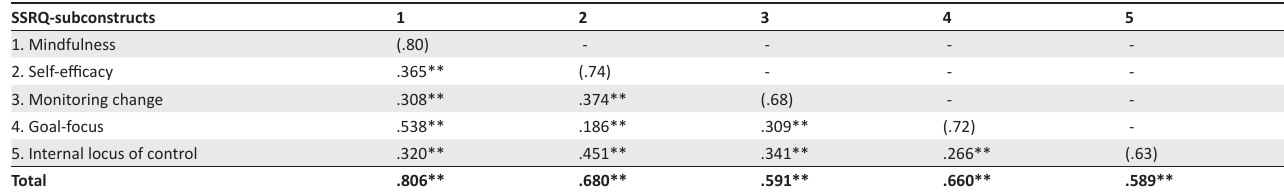
TABLE 3: Cronbach’s alpha reliability (in brackets) and component correlation matrix of the Short Self-Regulation Questionnaire. SSRQ-subconstructs